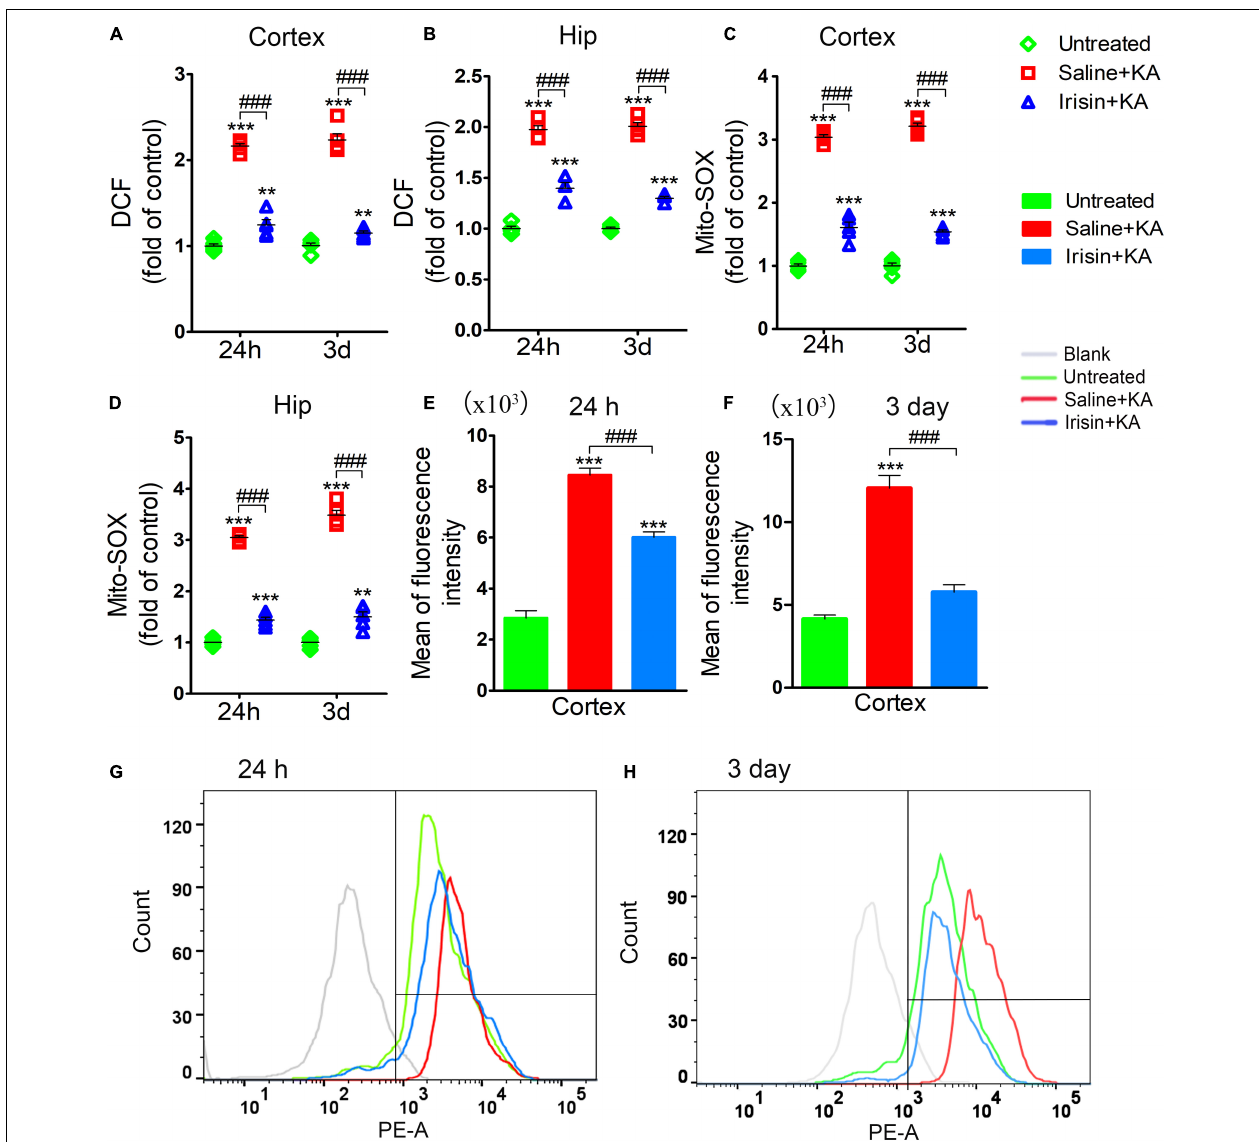
FIGURE 4 | Exogenous irisin treatment attenuated the elevated oxidative stress levels in rats with KA-induced SE. The elevated levels of DCF (A,B) and Mito-SOX (C,D) in the cortex and hippocampus induced by KA administration were decreased by exogenous irisin treatment. (E–H) The fluorescence intensity of Mito-SOX. 24 h, n = 5/group; 3 days, n = 8/group. ** P < 0.01, *** P < 0.001 compared with controls; ### P < 0.001 compared with each other (One-way ANOVA with Dunnett’s T3 post hoc test). Hip, hippocampus.